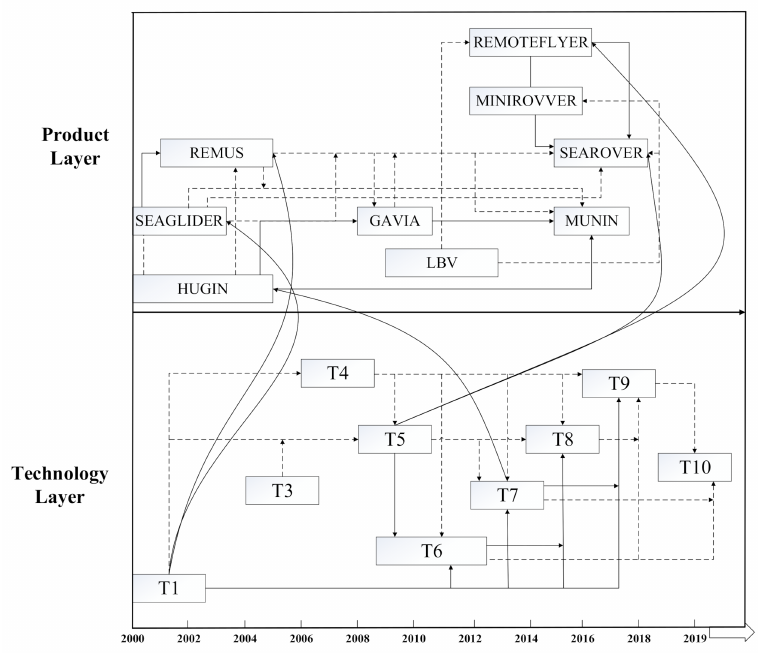
Figure 3. MA-based technology roadmap (TRM) for existing underwater